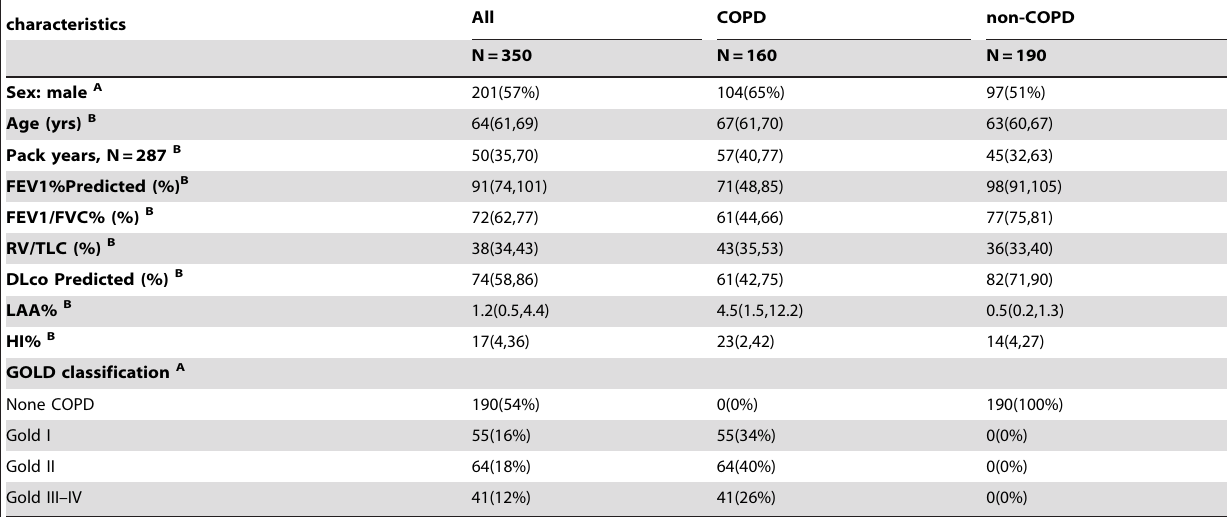
Table 1. Patient characteristics.